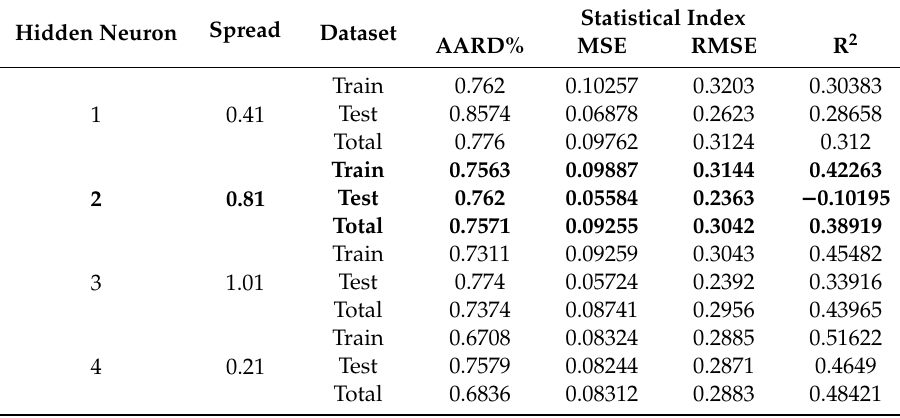
Table 6. Determination of the best hidden neurons for radial bias function (RBF).